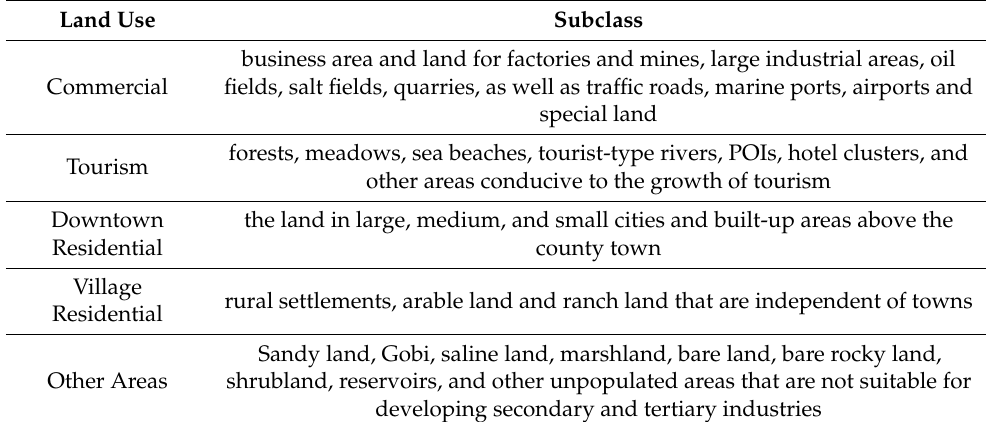
Table 1. Subclass of each land use